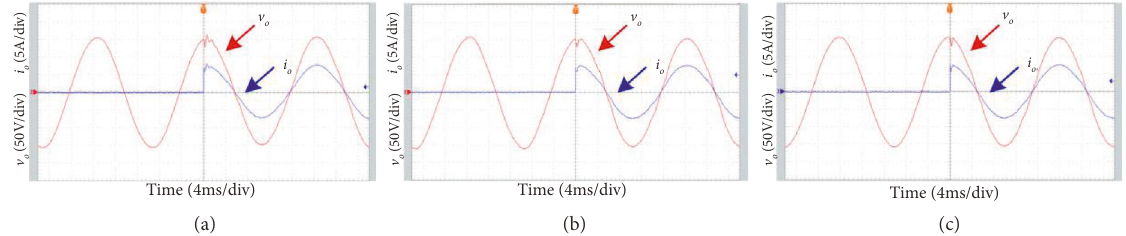
Figure 19: Transient waveforms in response to no load to rated load (20 Ω ) step change. (a) SRFPI, (b) LADRC, and (c) proposed SRFPI-